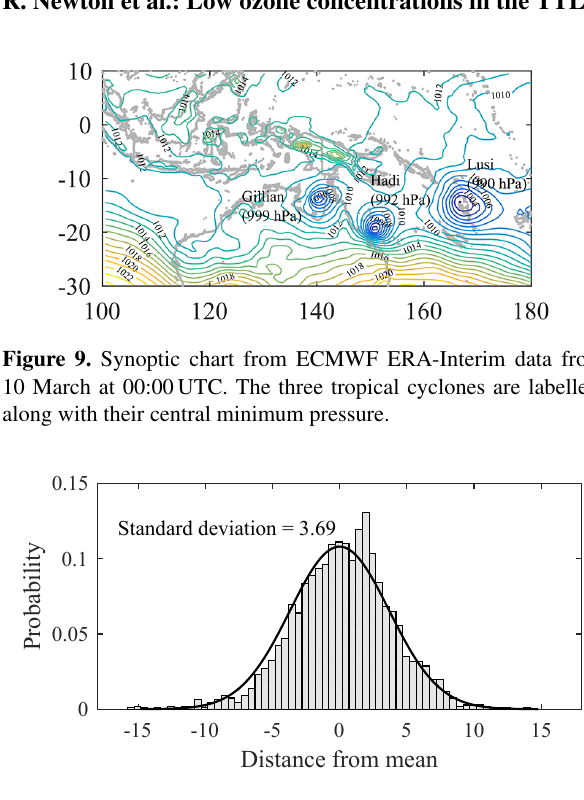
Figure 10. Histogram of departures of UCATS ozone measure- ments from the mean along each level section of flight.